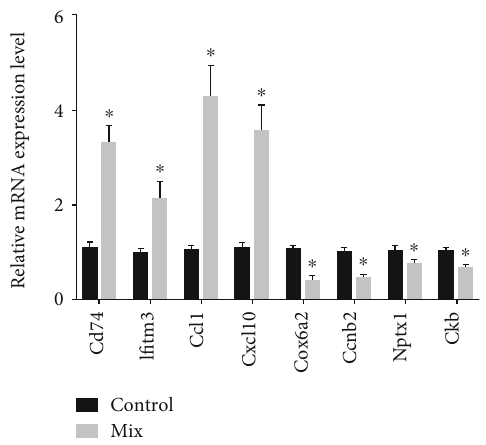
Figure 3: Validation for the expression of eight dysregulated mRNAs. MIN6 cells were incubated in the absence or presence of 2.5 ng/mL IL-1 β , 2.5ng/mL TNF- α , and 25 ng/mL IFN- γ (24 h incubation). The expression of the eight selected mRNAs was measured by qRT-PCR. The results are shown as the means ± SD for three independent experiments. ∗ P < 0 : 05 was considered statistically signi fi